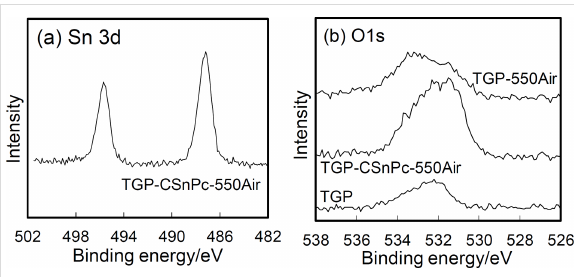
Figure 3: XPS spectra of (a) Sn 3d and (b) O 1s in TGP, TGP-CSnPc- 550Air, and TGP-550Air.